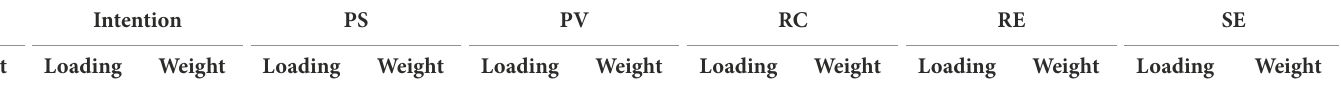
TABLE 3 Evaluation of measurement models and the reliability, validity, and normality of